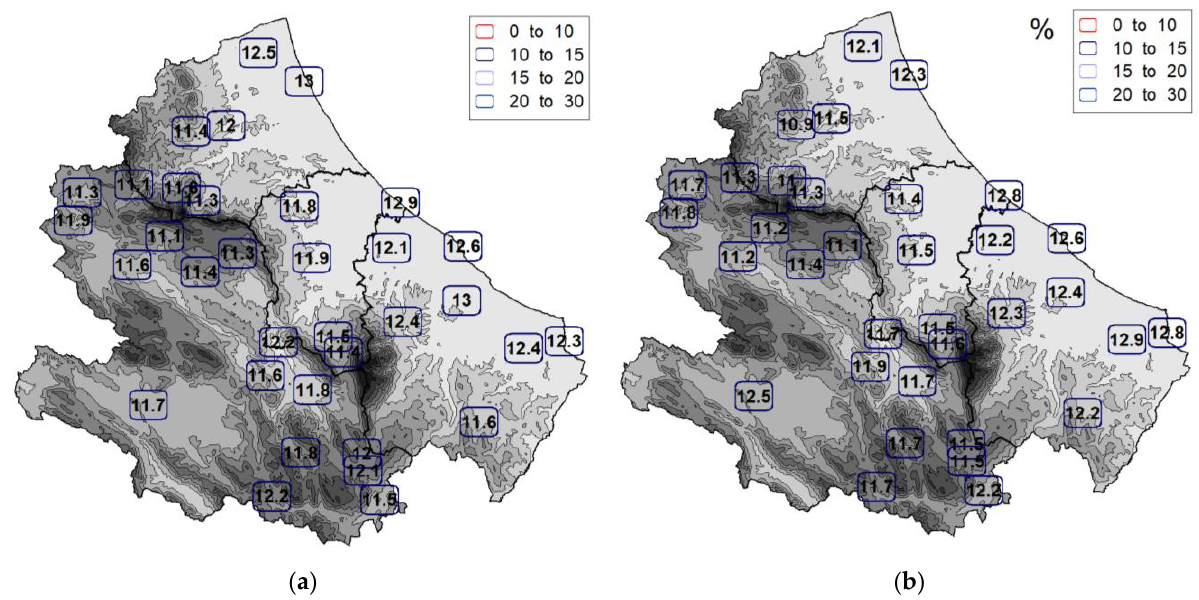
Figure 5. Spatial distribution of median PCI: ( a ) point data; ( b ) grid E-OBS data.